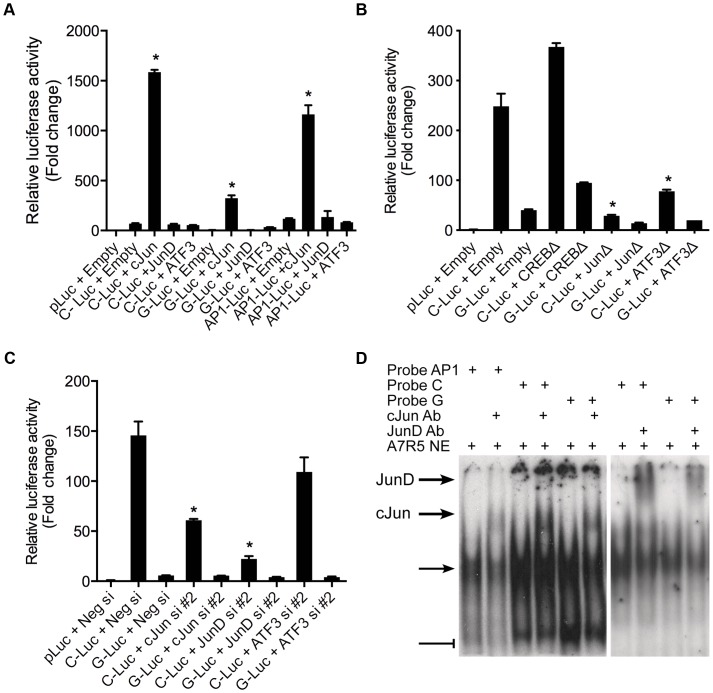
AP-1 dependent transcriptional regulation at rs12190287 in vitro.(a) Dual-luciferase assay of rs12190287-C and G variants determined in A7r5 cells transfected with rs12190287 enhancer (C-Luc and G-Luc), consensus AP-1 reporter (AP1-Luc) or empty reporter (pLuc), along with human c-JUN, JUND, or ATF3 expression vectors and measured after 24 hours. *P<0.0001 versus C-Luc, G-Luc or −1-Luc+Empty where indicated. (b) Dual-luciferase assay of rs12190287 enhancer in A7r5 cells transfected with empty vector (Empty) or dominant negative expression constructs for human CREB (CREBΔ), c-JUN (JunΔ), or ATF3 (ATF3Δ). *P<0.01 versus C-Luc+Empty. (c) Dual-luciferase assay of rs12192087 enhancer in heterozygous HCASMC transfected with small interfering RNA duplexes (siRNA) against c-JUN, JUND, ATF3 or a negative control (Neg si). *P<0.01 versus C-Luc or G-Luc+Neg si. (d) EMSA of rs12190287 C/G enhancer showing specific shifted complexes (arrow) and JunD and c-Jun super-shifted complexes (bold arrows). Bar-head line denotes non-specific shifted complexes. Values are normalized mean ± SD from triplicates. Similar results were observed from three independent experiments.